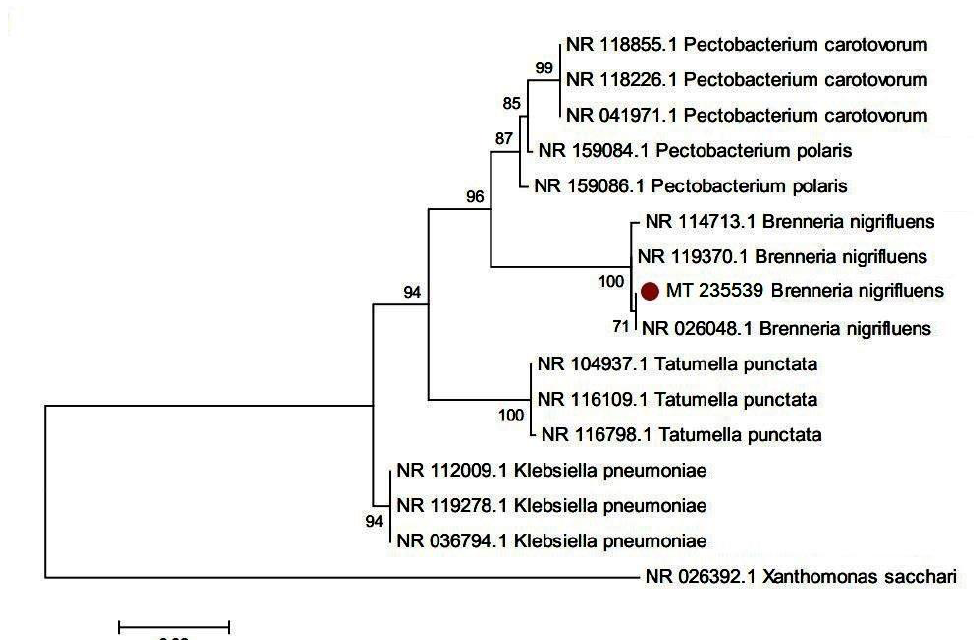
Fig. 4. Phylogenetic analysis of representative strain and related species by the neighbor-joining method based on 16S rRNA gene sequences: The GenBank accession number for each microorganism used in the analysis is shown behind the species name. Bootstrap values are shown at the nodes. The tree was rooted with Xanthomonas sacchari .